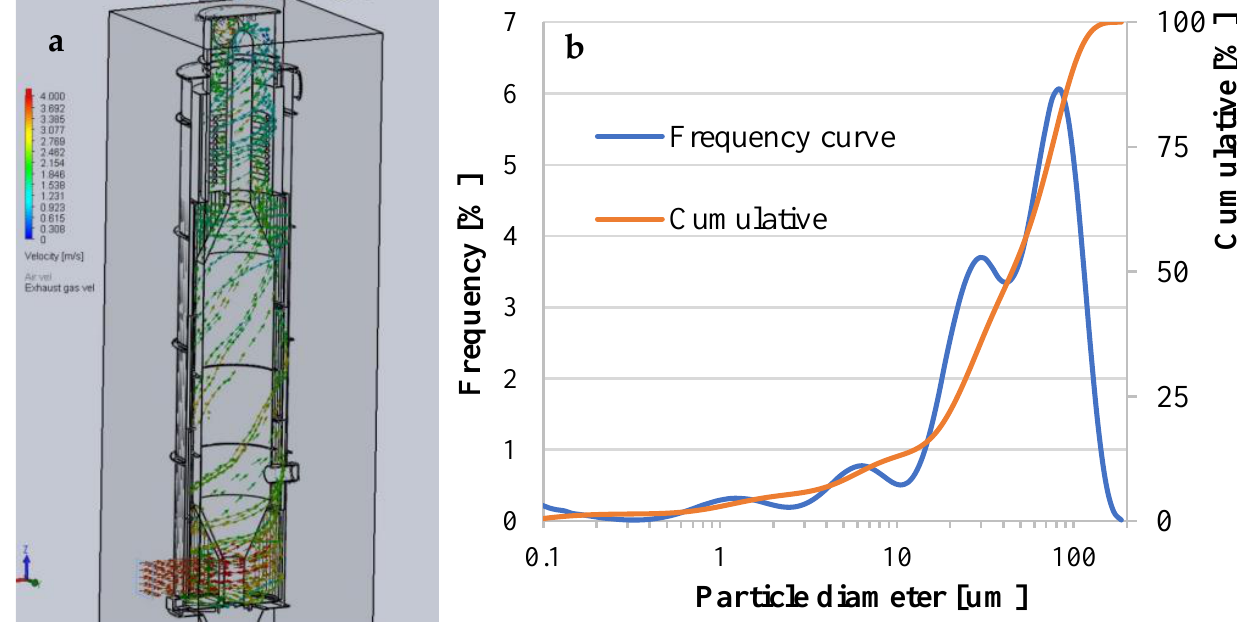
Figure 5. ( a ) Computer simulation of the exhaust gas flow velocity inside the drying chamber. (b ) Particle distribution obtained from the exhaust gas.